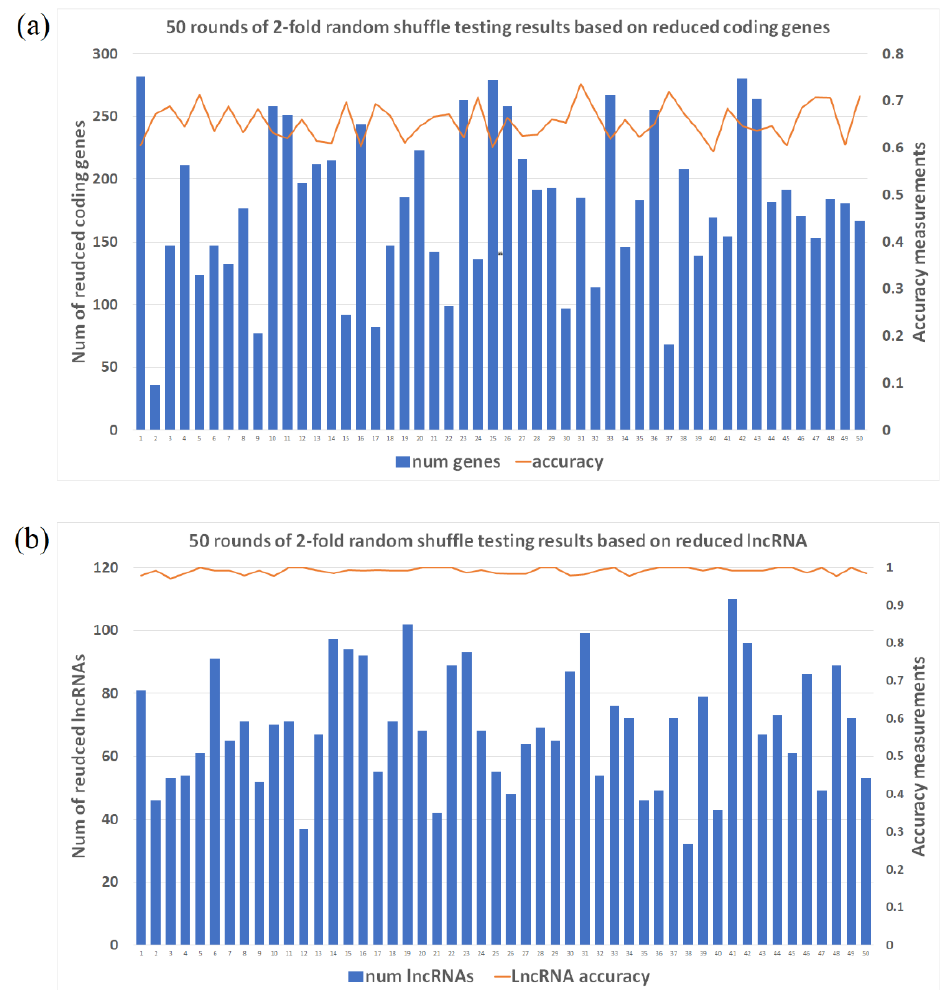
Figure 1. Two-fold random shuffle testing results for 50 rounds. X -axis is the round number, Y_1 axis (left) is the number of reduced genes ( a ) and lncRNAs ( b ), Y_2 axis (right) is the accuracy measurement ranged from 0 to 1.